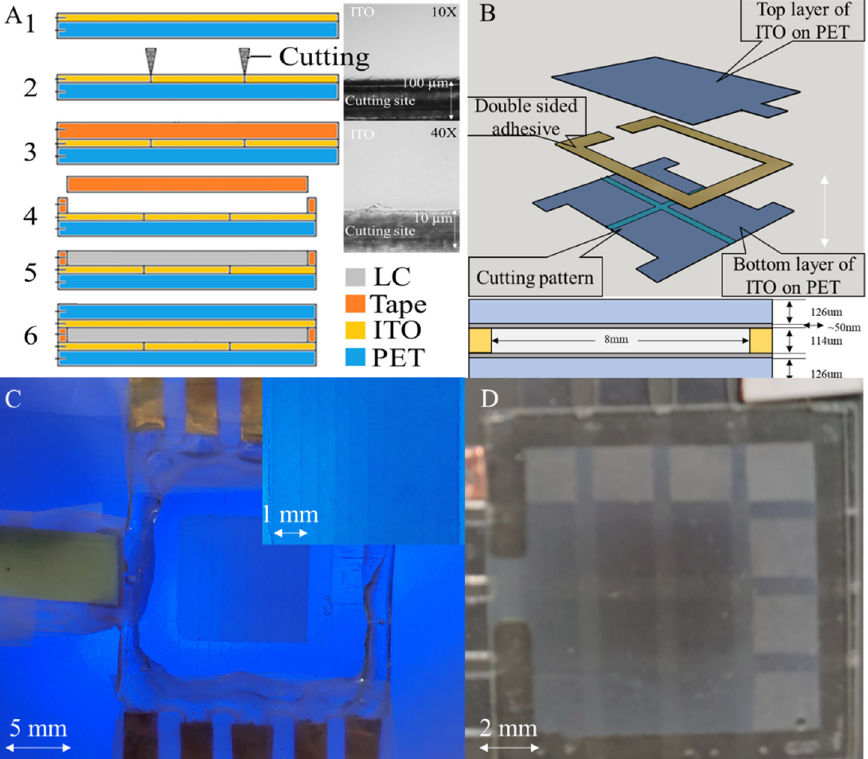
Figure 1. ( A ). Schematic of the device fabrication process and 10X and 40X optical microscopic image of the cutting site. ( B ). Schematic diagram showing the layer structure of the NLC shutter. ( C ). A working NLC shutter under different voltages (10 V to 100 V from left to right, with 10 V increment per channel), demonstrating its tuning capability. ( D ). A working NLC shutter showing multiple channel controllability (4 mm 2 per channel).